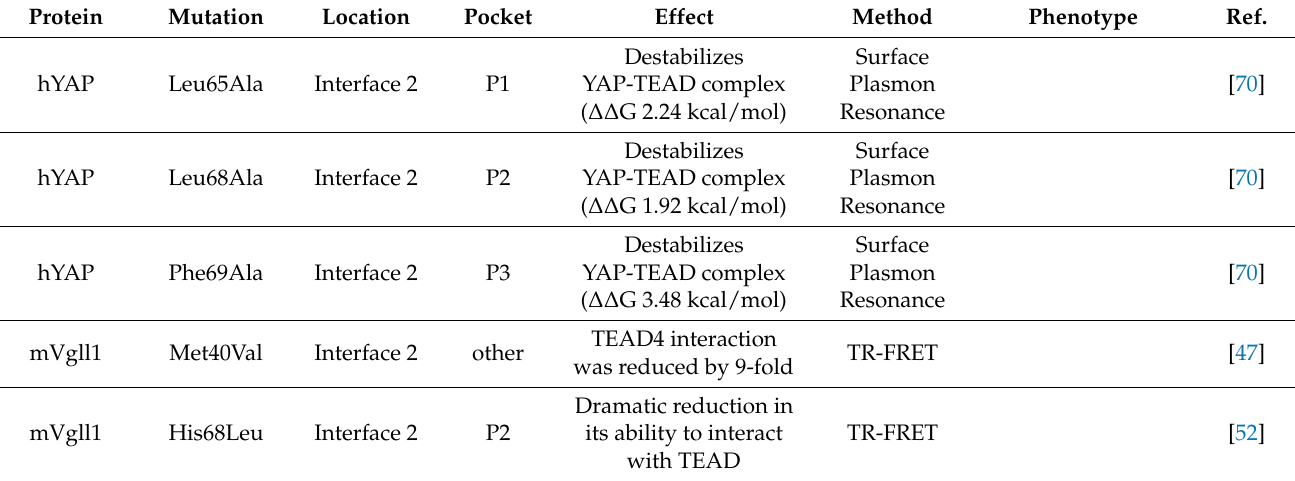
Table 2. Mutations of the residues of coregulator proteins and TEADs. Protein